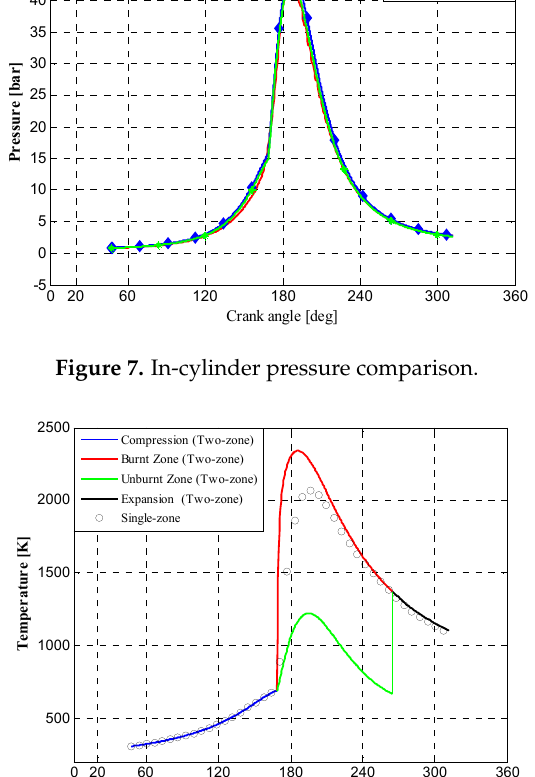
Figure 7. In-cylinder pressure comparison.